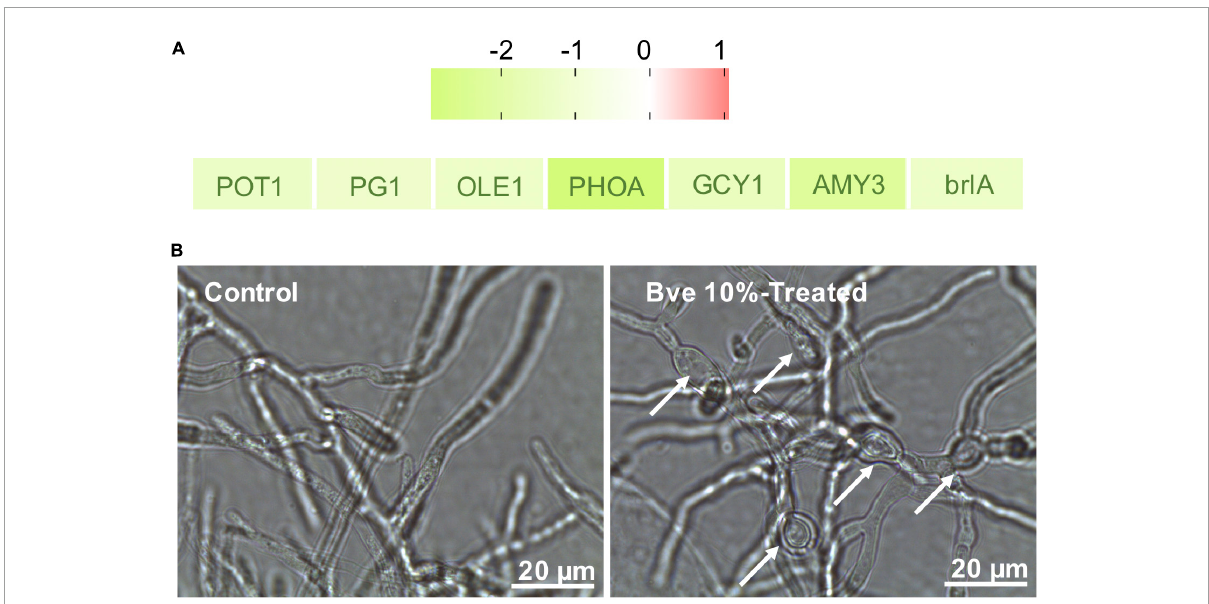
FIGURE11 Identification of differentially expressed genes (fold change > 1) involved in plant–pathogen interactions by RNA sequencing (A) . Microscopic morphology of Penicillium olsonii after exposure to Bacillus velezensis (5 days after inoculation) metabolites. White arrows indicate mycelial swelling caused by 10% B. velezensis metabolites (B) .